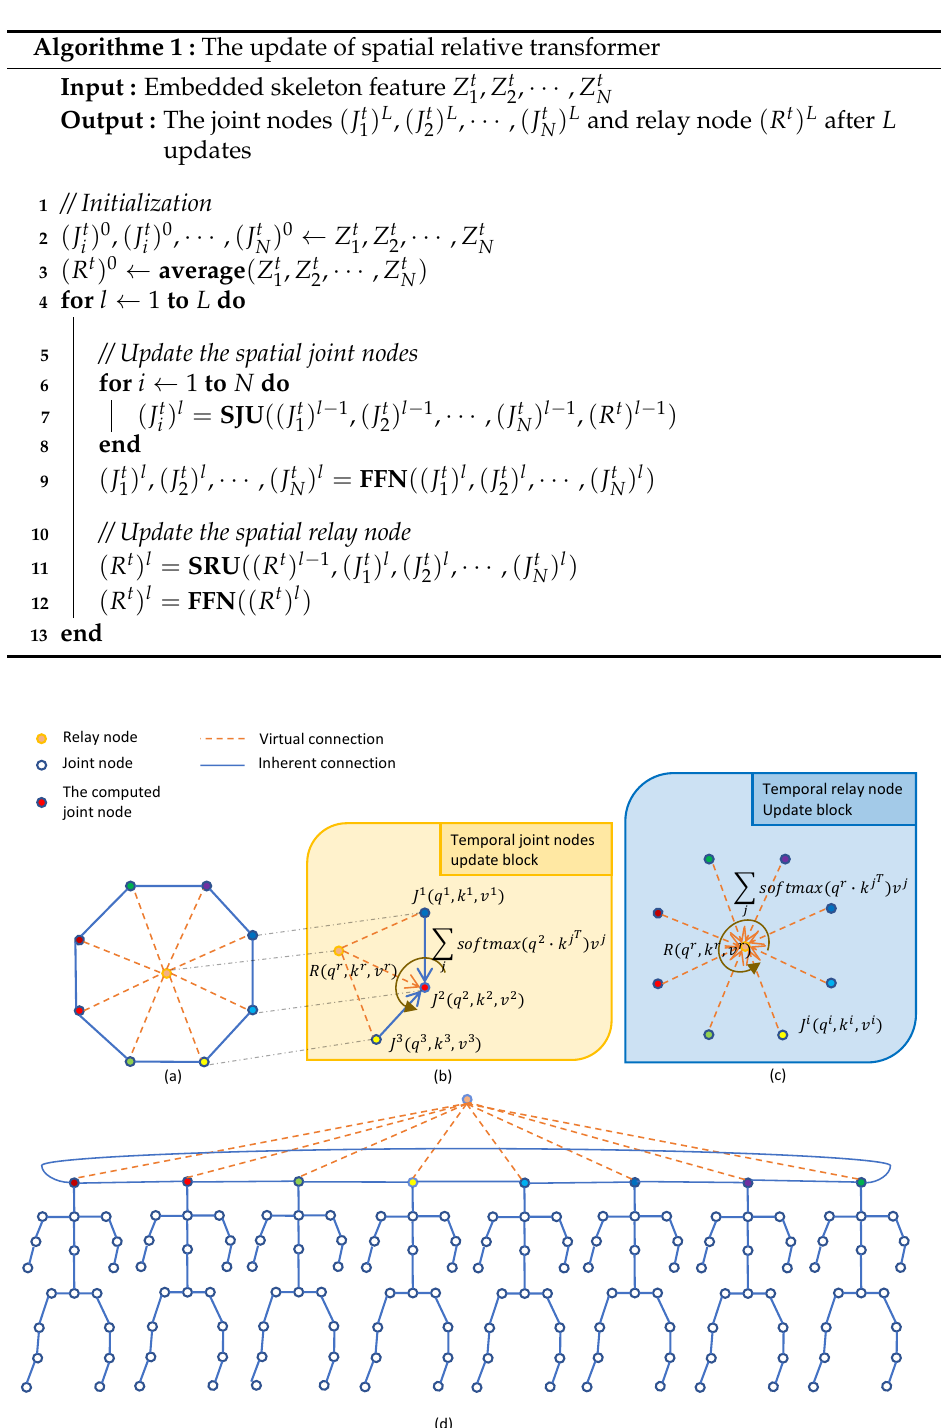
Figure 5. Illustration of the update blocks in temporal relative transformer (TRT). The same joint nodes in all sampled skeleton are connected in order and the joint nodes in the first and last frame are also connected in ( d ). This approach constitutes a ring-shaped structure, as shown in ( a ). Furthermore, each joint node and the temporal-relay node are updated by TJU in ( b ) and TRU in ( c ), respectively, similar to the methods in